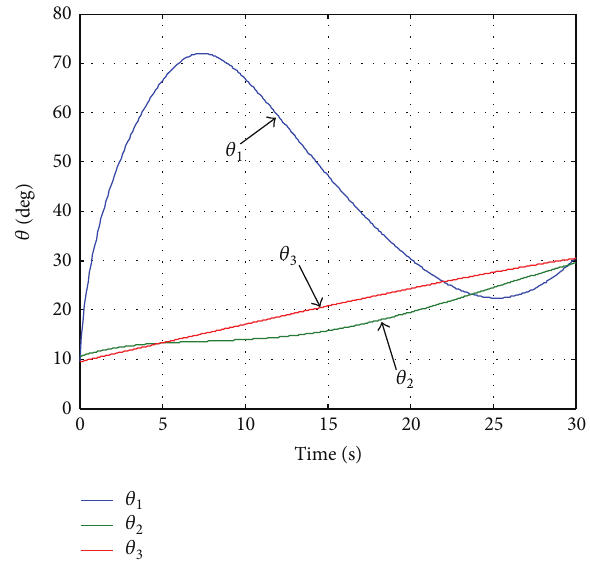
Figure 11: Joints angular displacement with initial errors (simula- tion